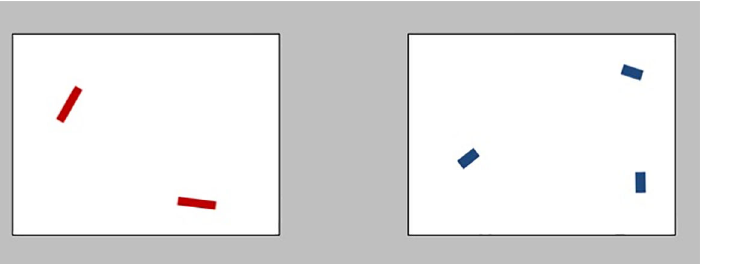
Figure 5a. A 2:3 ratio comparison in the small numerosity condition in Experiment 3 (size-number incongruent).